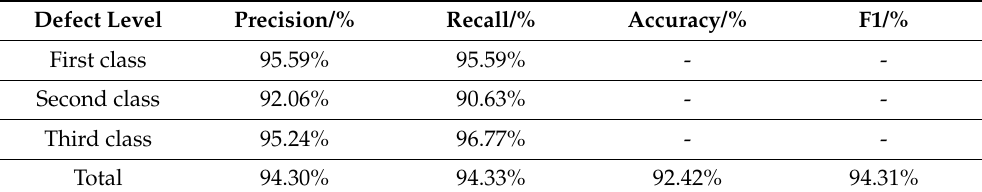
Table 4. The average of detection results of three grades.